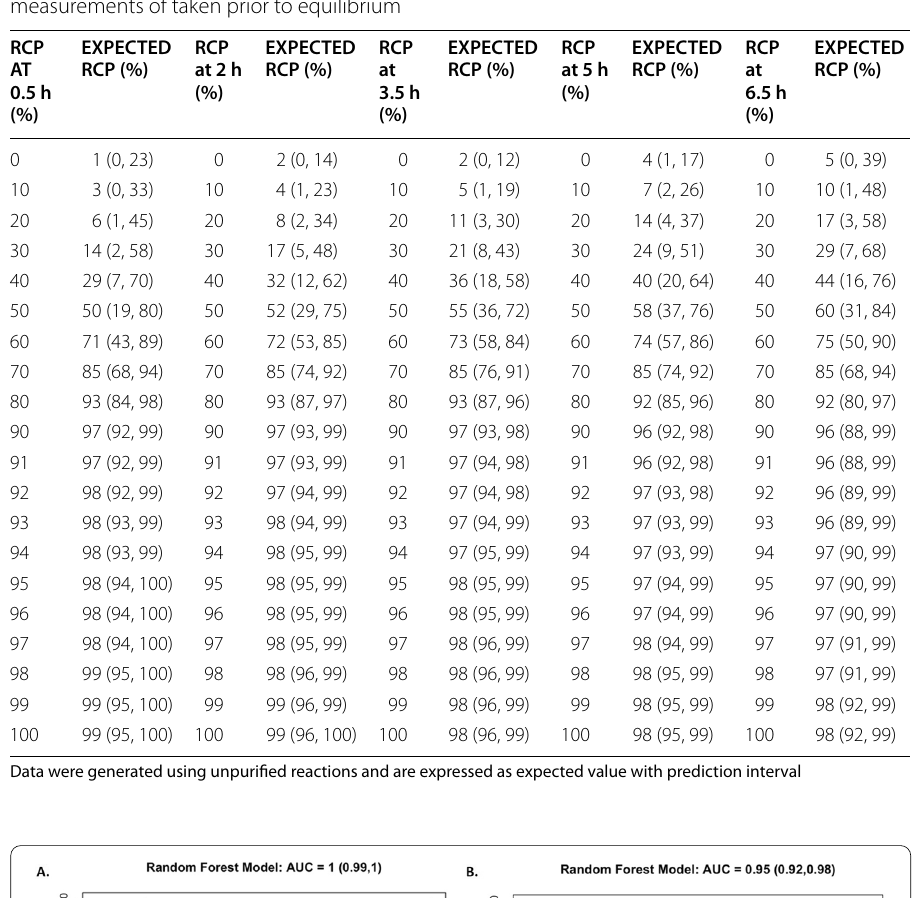
Table 2 Predicted RCP, defined as the RCP measured at secular equilibrium, based on measurements of taken prior to equilibrium